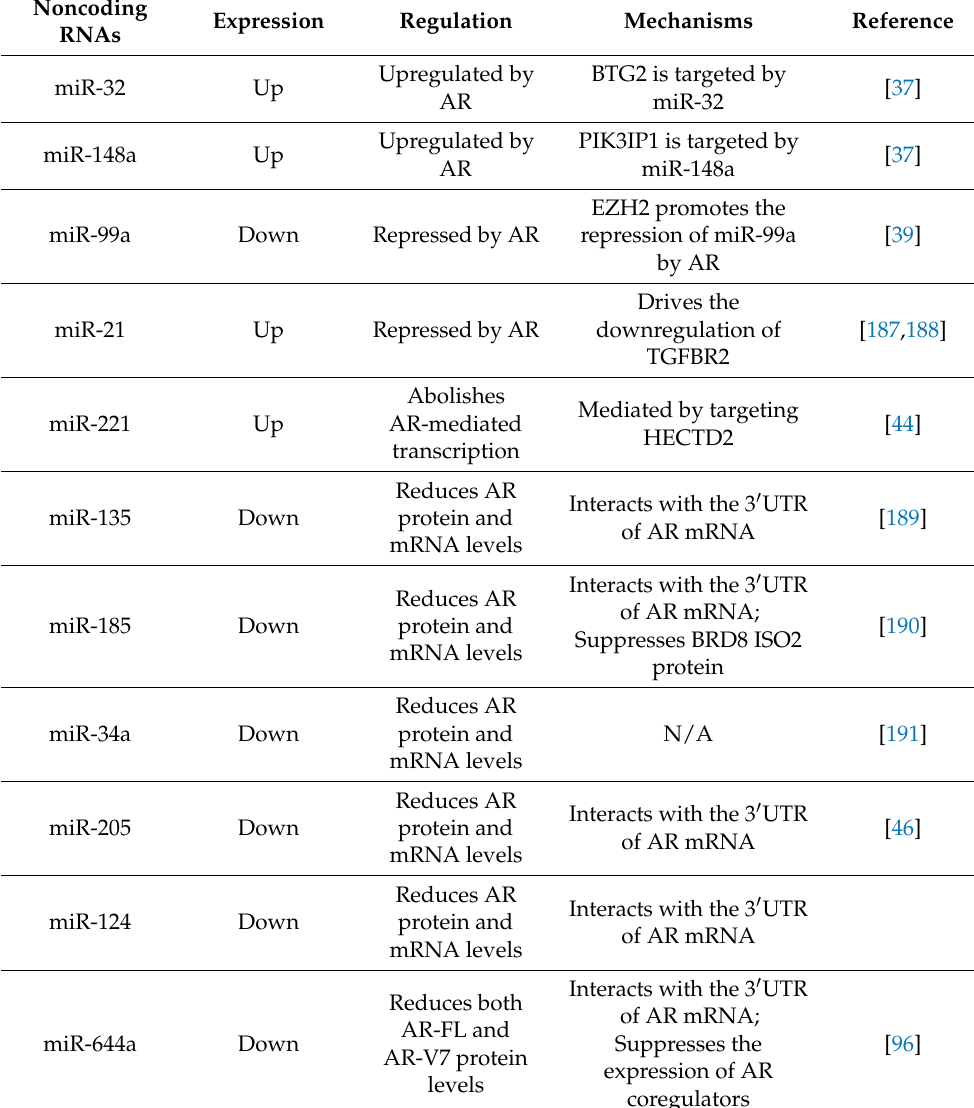
Table 2. Representative AR-related ncRNAs and molecular mechanisms involved in CRPC. Noncoding